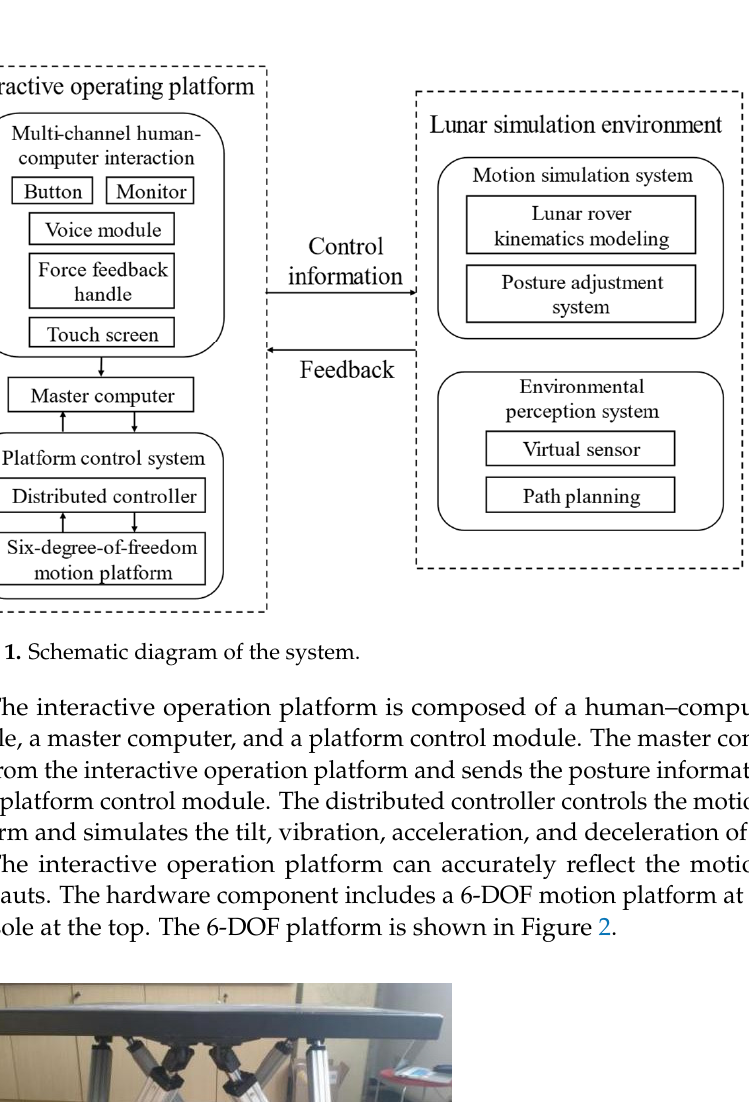
Figure 2. 6-DOF motion platform.